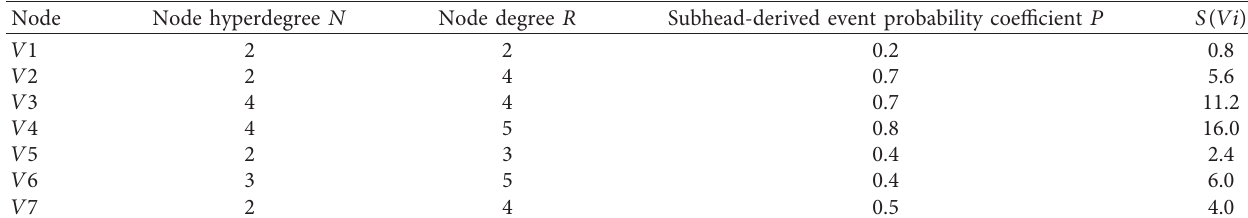
Table 2: Analysis of the affected extent of nodes.